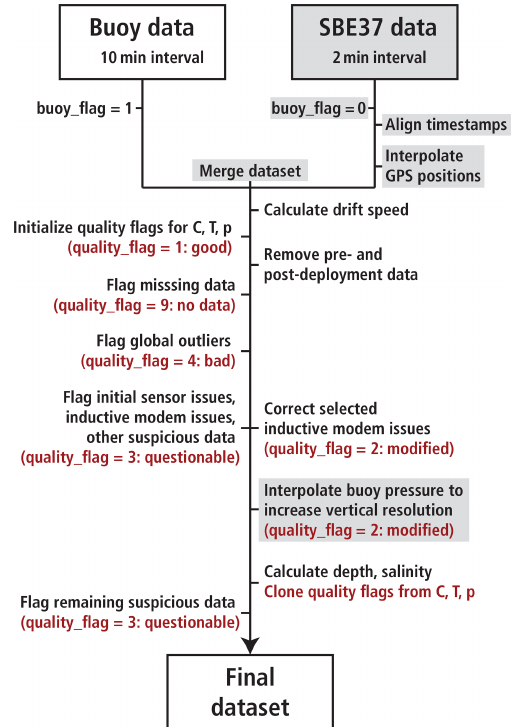
Figure 2. Schematic outlining the individual steps of data process- ing and quality control using primary flags (indicated in red) ac- cording to a slightly modified version of UNESCO-IOC (2013). The additional processing steps required when merging buoy and recovered CTD data are indicated in gray. Procedures to the left of the processing arrow represent flagging without modification of the original data, whereas processing steps to the right involve re- moval and modification of original data or calculation of secondary parameters.